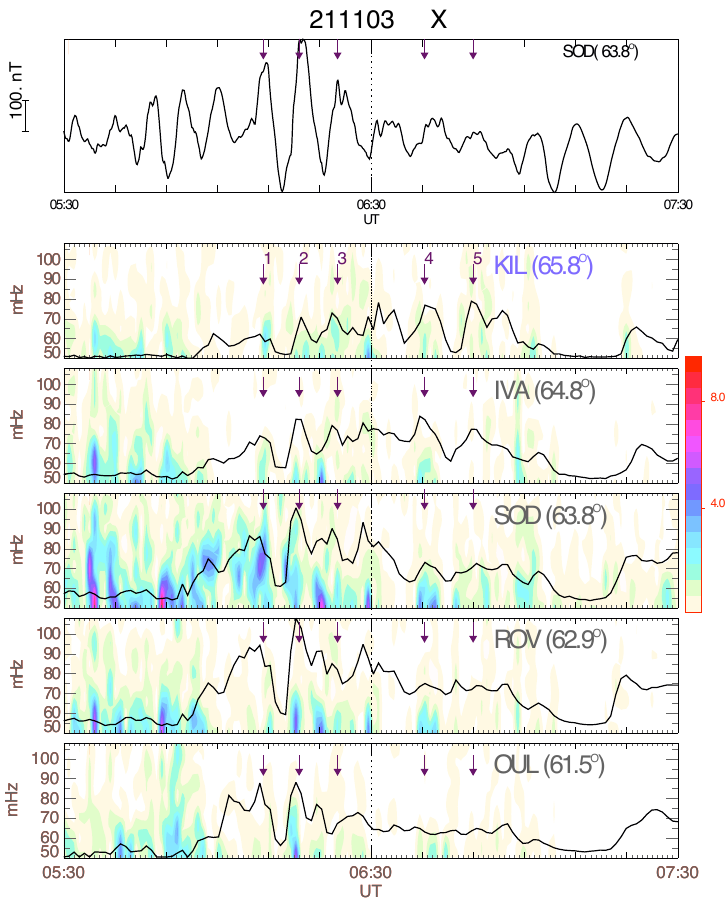
Fig. 6. The dynamic power spectra of Pi1 type short period (f=50–100mHz) magnetic pulsations (in arbitrary units), collected from five Finnish stations, in comparison with riometer data (black lines) and Pc5 pulsations. The arrows with numbers indicate that the short bursts of Pi1 coincided with the absorption peaks (see Fig.